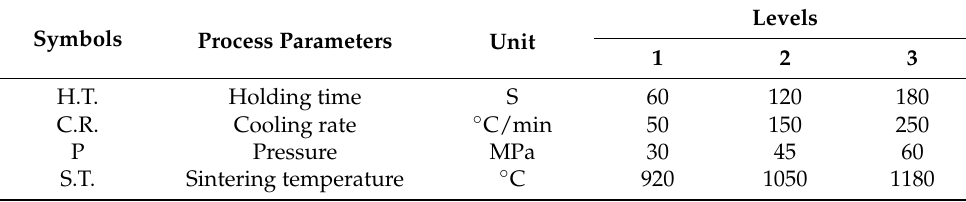
Table 2. Sintering process parameters and their